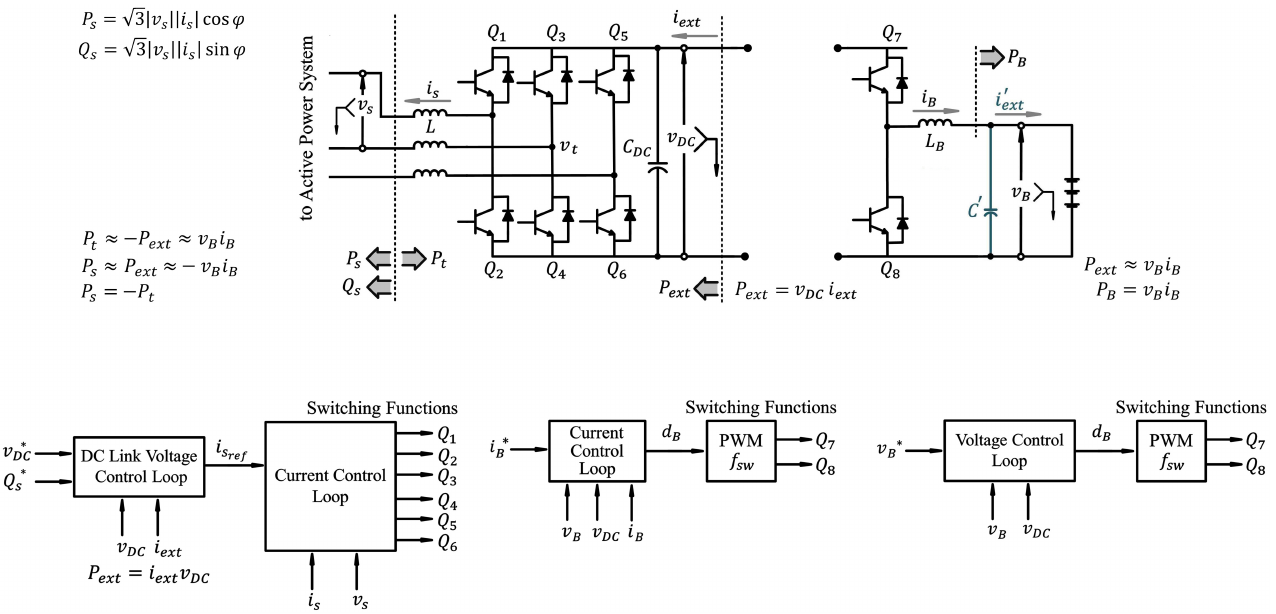
Figure 1. Common three-phase configuration for EV battery chargers with its control